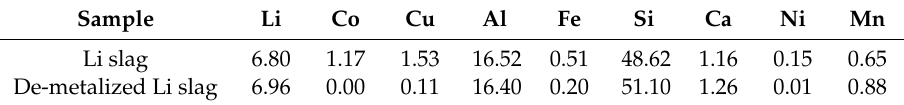
Figure 2. Metal phases obtained by magnetic separation: ( a ) after crushing ( b ) after grounding. Table 1. Chemical composition of the slag before and after magnetic separation.